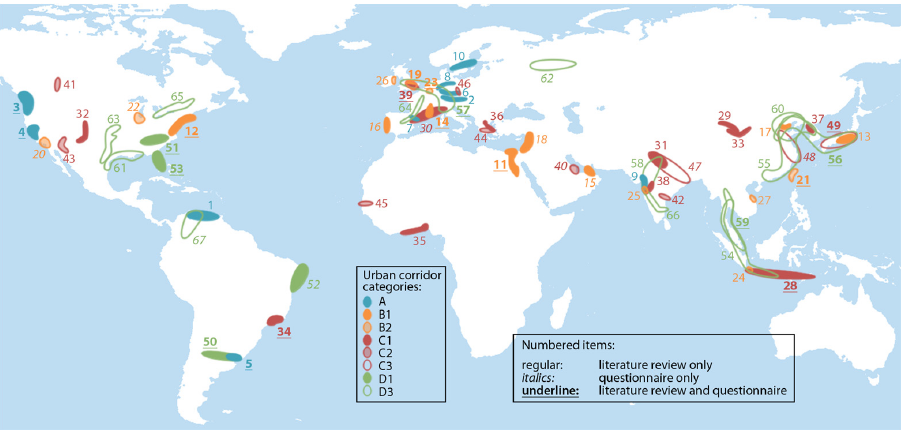
Figure 7. Global inventory of urban corridors. Corridors numbered according to Table 2.